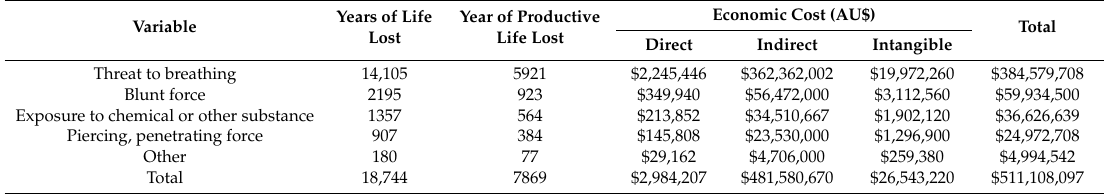
Table 5. The total economic cost of youth suicide, Australia, 2014, by means of suicide.